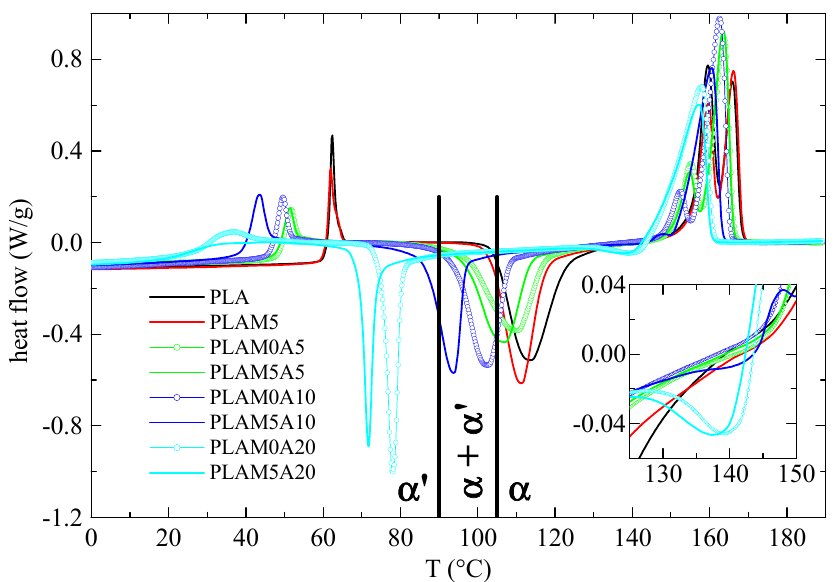
Figure 3. DSC first melting curves (endo up) at 10 °C/min of the different compression-molded materials. The vertical lines are the corresponding values reported in reference [22], showing the temperature intervals where the pure α ’ or α modifications are expected to be observed (or the interval where both forms coexist) in this PLA under analysis.